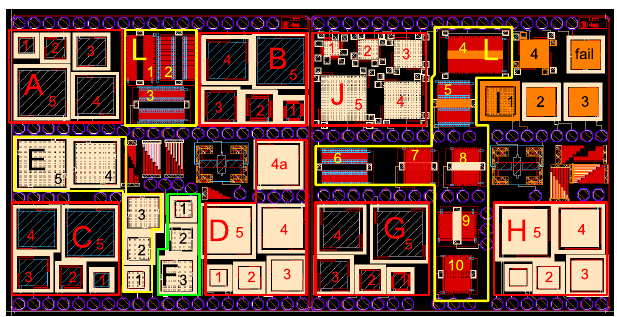
Figure 3. Accused —the first CMOS-MEMS test-chip in IHP SG25 BEOL-only process. The dimensions are 2 mm × 4 mm.